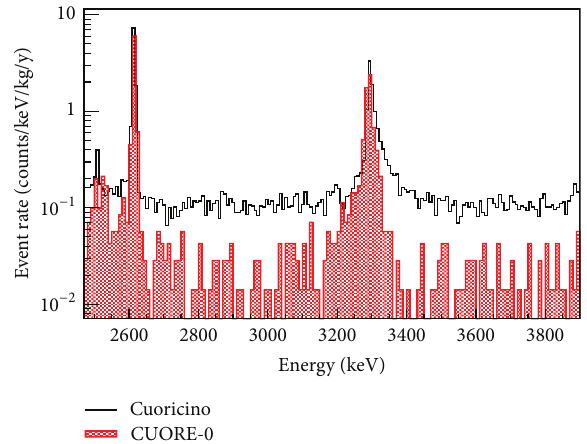
Figure 6: Background spectra from CUORE-0 (shaded, red) and Cuoricino (black) in the energy region dominated by degraded 𝛼 particles [24]. The sixfold reduction in background achieved by CUORE-0 in the energy ranges 2.7–3.1 MeV and 3.4–3.9 MeV is clearly evident. The prominent peak at 3.3 MeV is from decay of 190 Pt, which is present in the TeO 2 crystals from their growth. The non-Gaussian shape of the peak is due to the fact that these spectra are made by summing the contributions from many detec- tor channels having different (Gaussian) energy resolutions and positions, the variations in the latter arising because of calibration